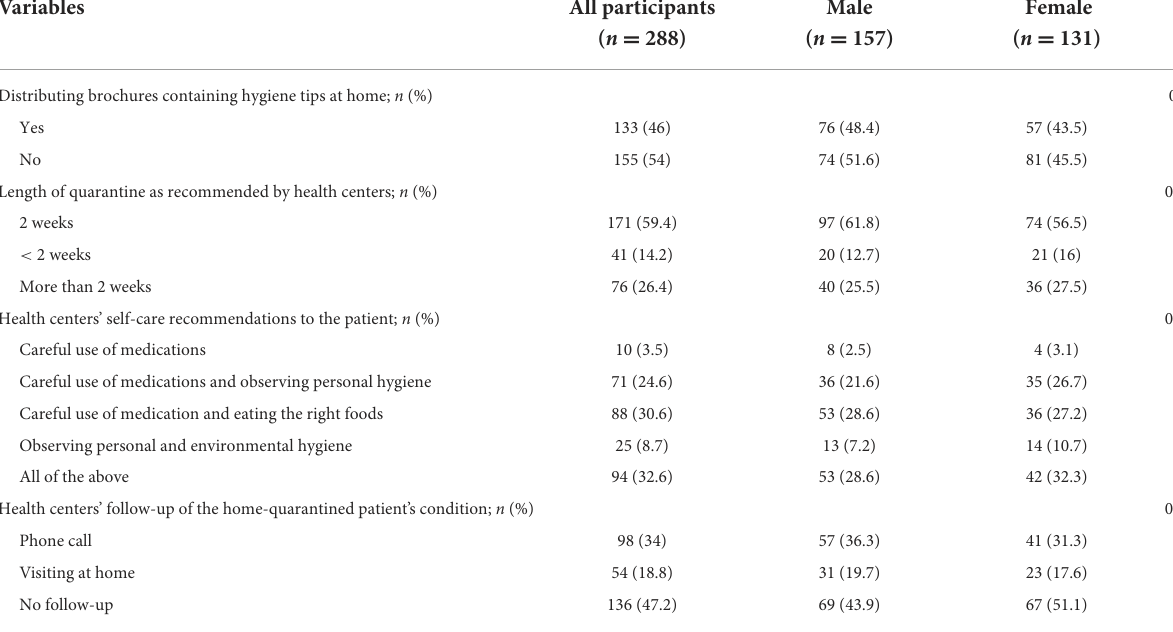
TABLE 3 Health centers’ supervision and guidance concerning the patient’s condition at home.